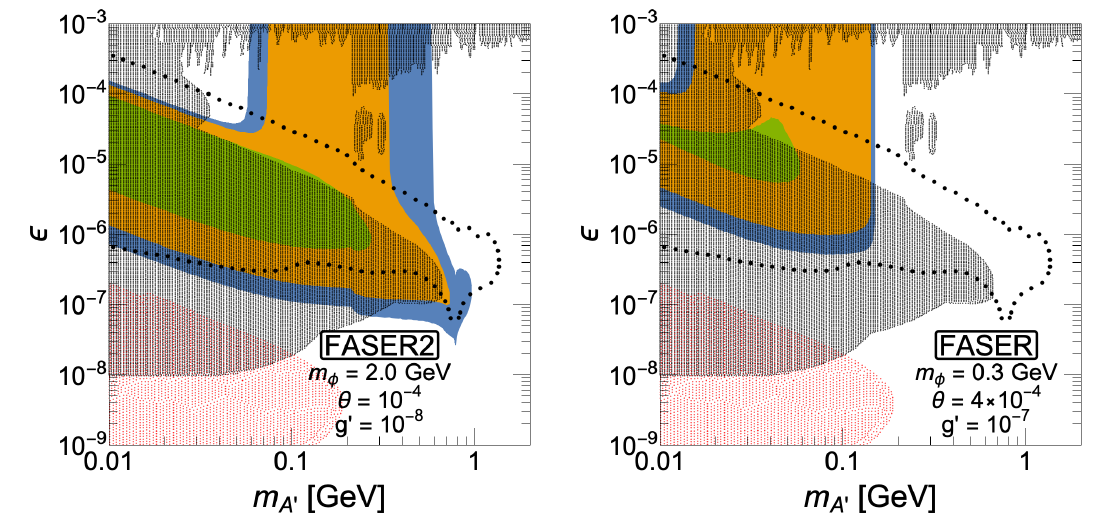
Figure 1 . Expected number of the signal events of the dark photon after correcting the φ decay